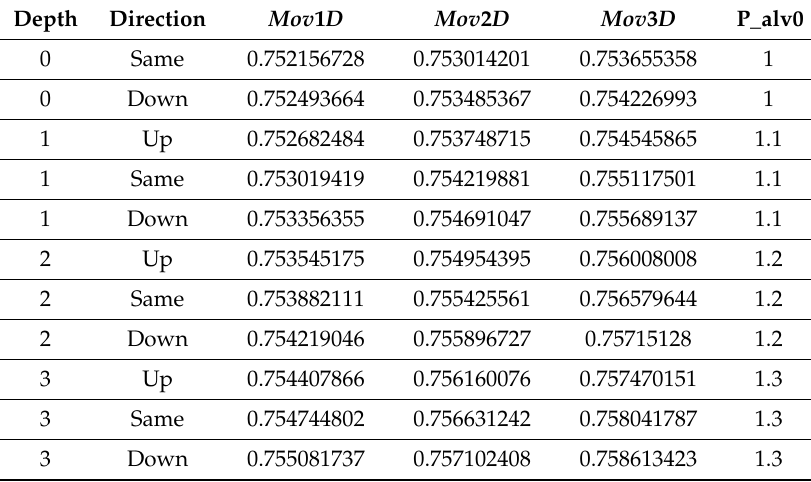
Table 1. A part of the decompression cost